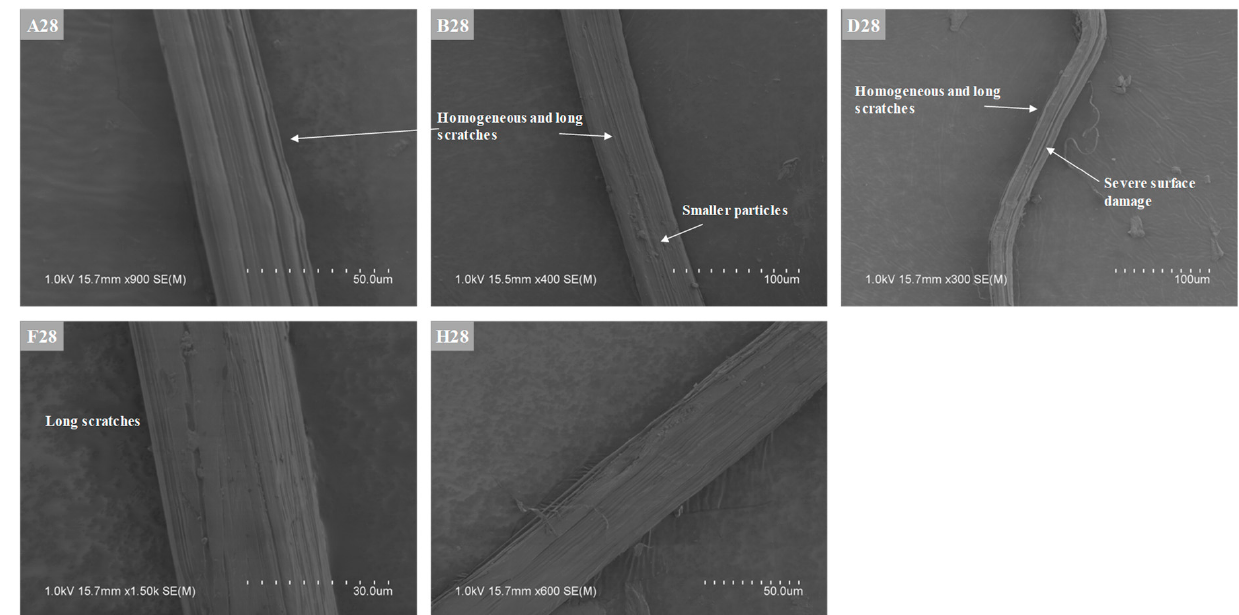
Figure 12. SEM images on polyethylene (PE) fibers pulled out of 7 d cured specimens.